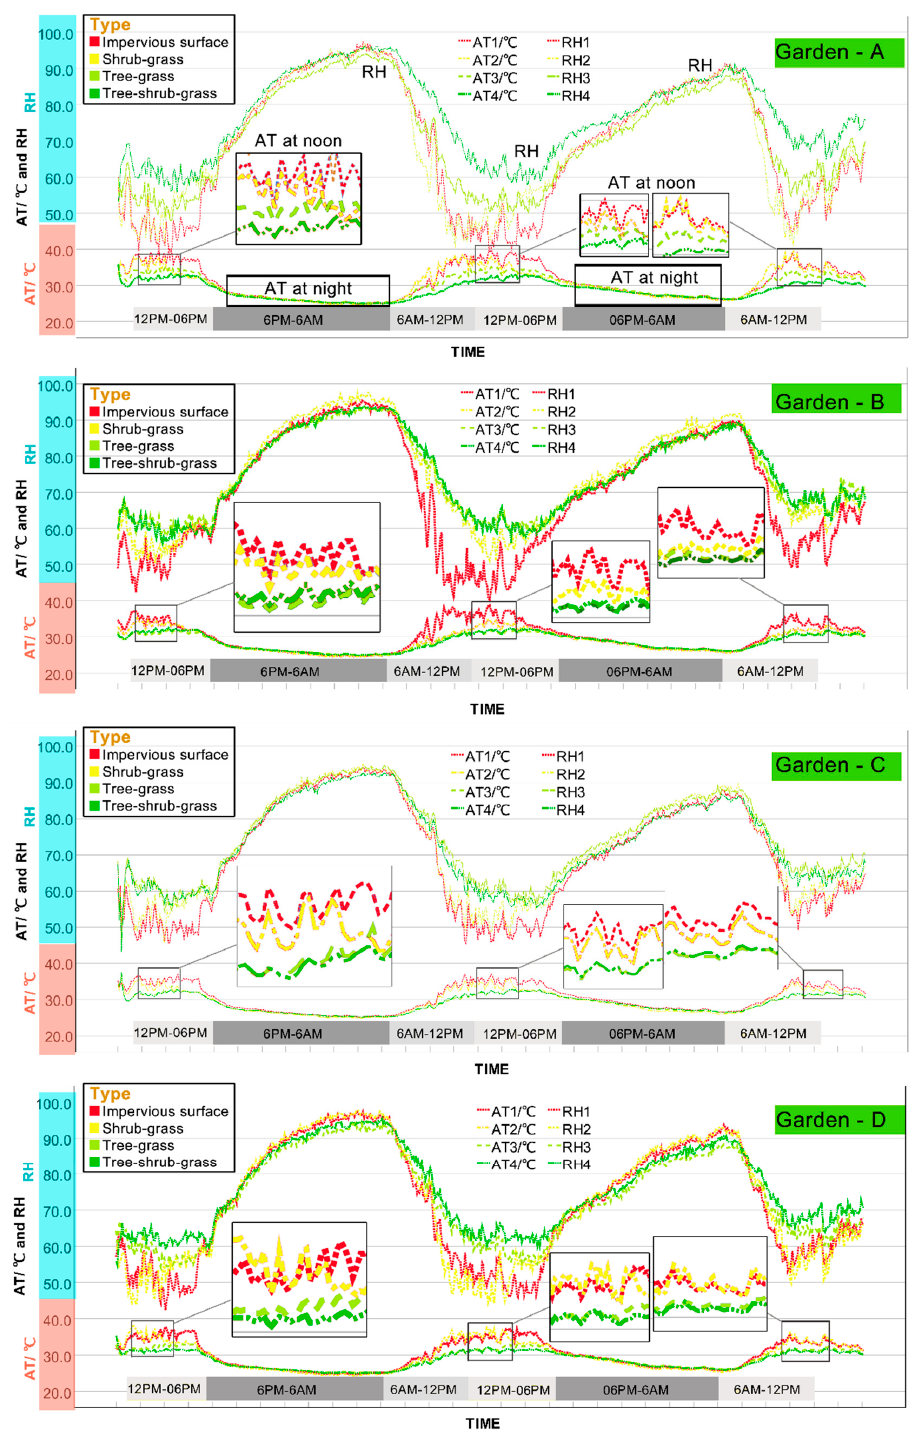
Figure 6. Air temperature (AT) and relative humidity (RH) changes of 16 points in four gardens (A; B; C; D) during the measurement period (7–9 August 2019). Coverage types: Red—Impervious surface; Yellow—Shrub-grass; Light green—Tree-grass; Dark green—Tree-shrub-grass.